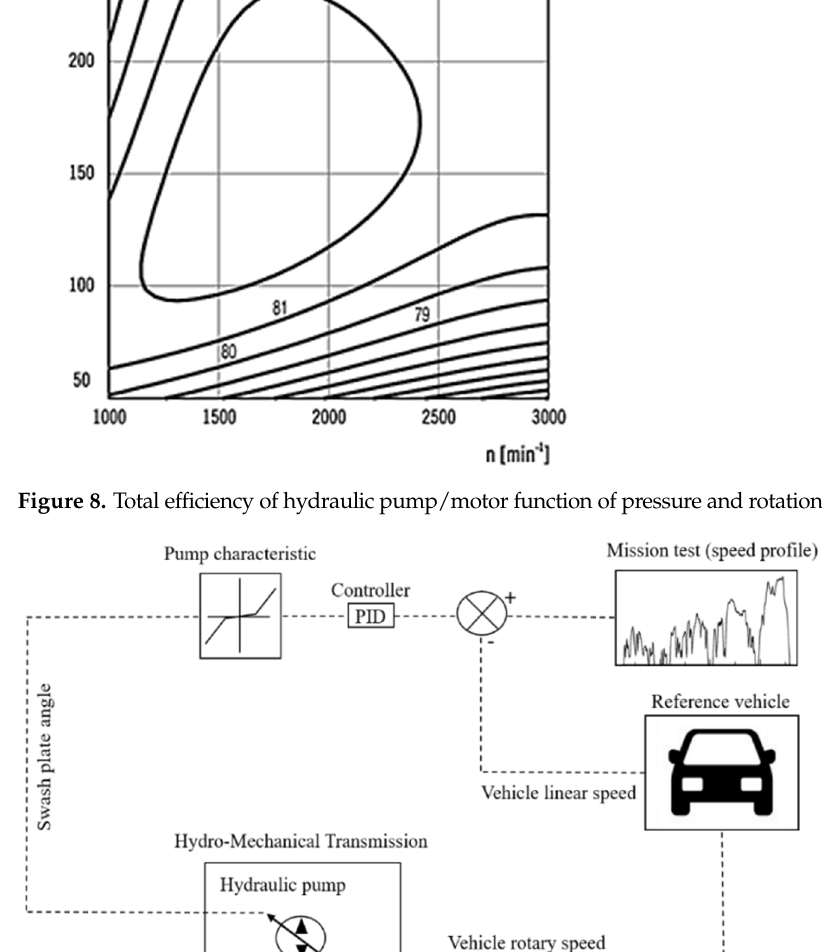
Figure 9. Pump displacement control strategy.